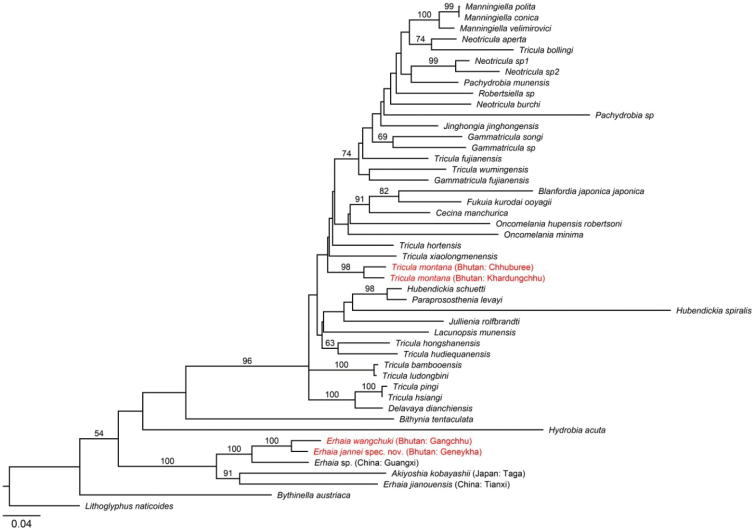
Maximum likelihood tree reconstructed with RAxML BlackBox (Stamatakis et al. 2008; GTR+G substitution model for each partition and 100 bootstrap replicates) based on the 16S rRNA and COI dataset of Liu et al. (2014) and Guan et al. (2008), with new data in red. Numbers on branches denote bootstrap values >50.